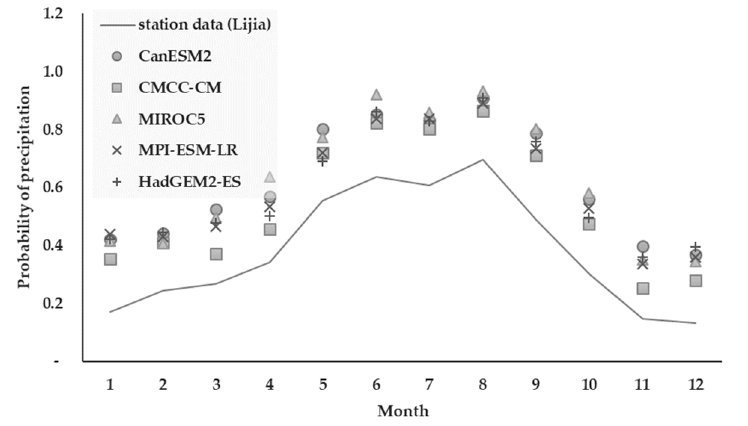
Figure 11. Bias correction result in probability of precipitation of the No-Threshold method.